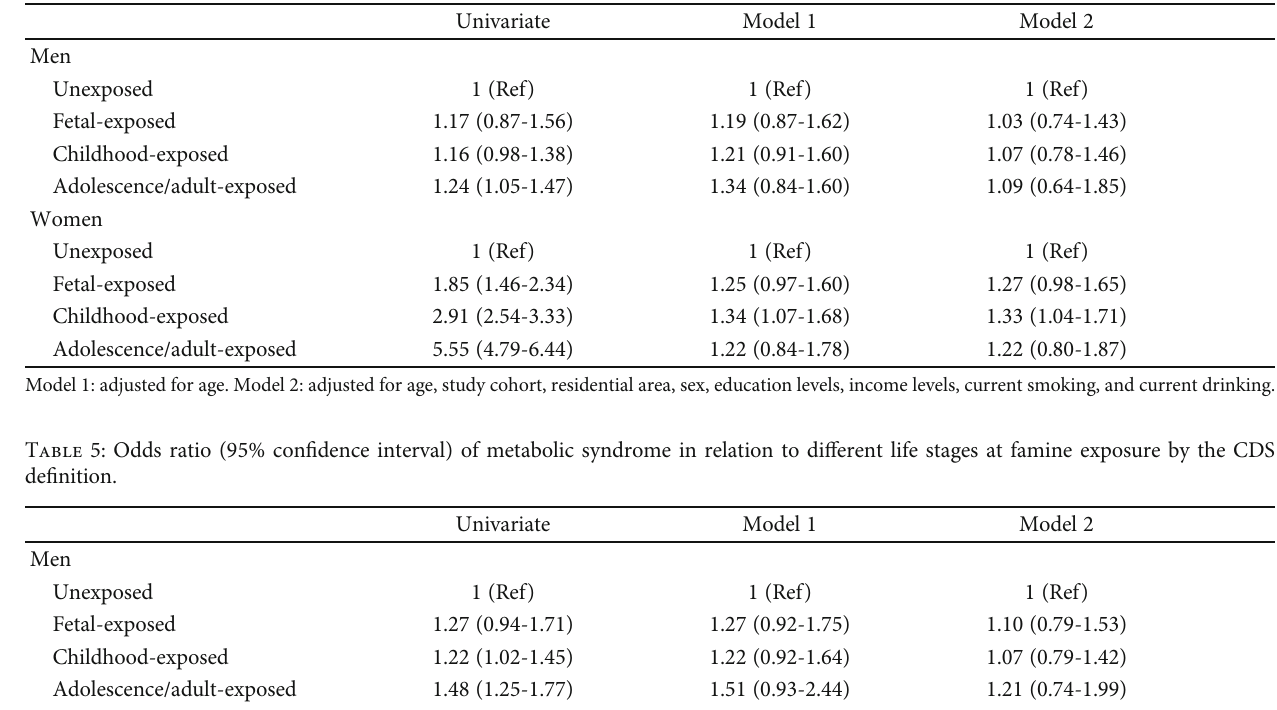
Table 4: Odds ratio (95% con fi dence interval) of metabolic syndrome in relation to di ff erent life stages at famine exposure by the NCEP-ATP III de fi nition.